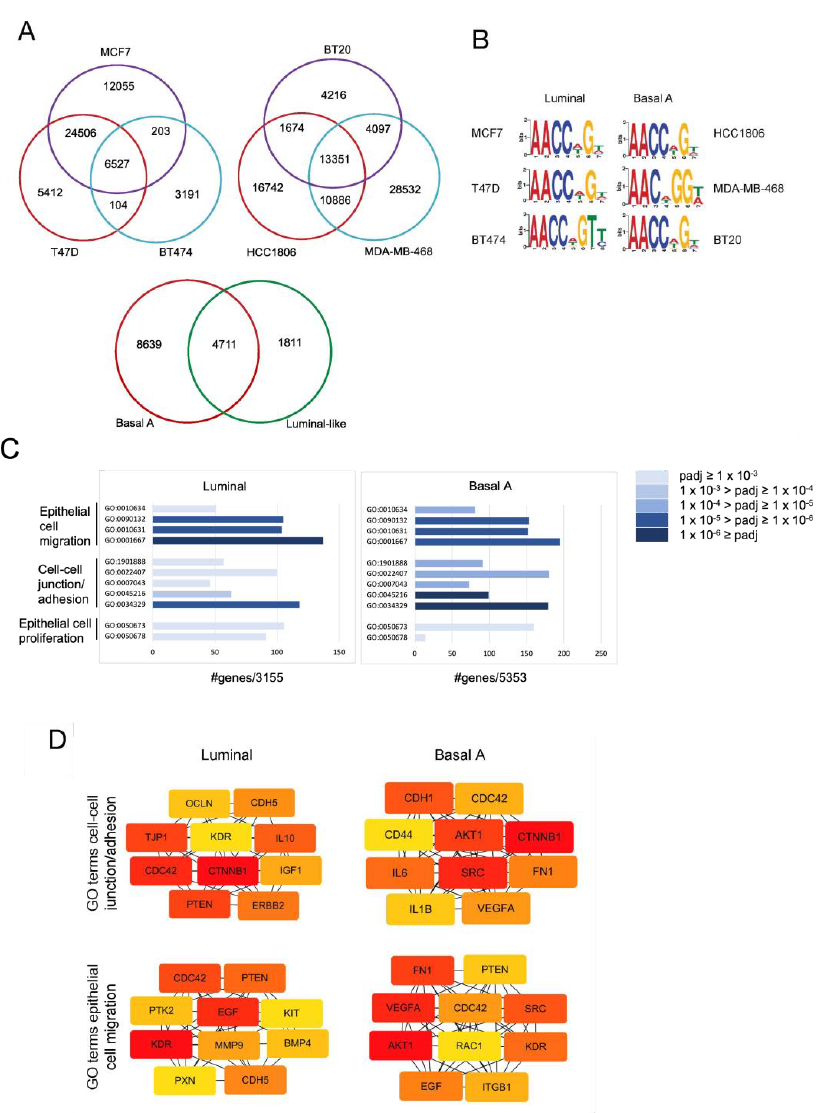
Figure 3. ChIP-seq analysis of GRHL2 target genes in luminal and basal A cells. ( A ) Venn diagrams showing overlap of GRHL2 binding sites among the indicated luminal and basal A cell lines (top panels) and overlap between shared GRHL2 binding sites in luminal and basal A cell lines (bottom panel). ( B ) GRHL2 DNA-binding motifs identified in the indicated cell lines. ( C ) Enriched GO terms associated with the indicated functions for GRHL2-occupied genes shared between all luminal (left panel) or all basal A cell lines (right panel). Color coding according to padj values in the legend. X-axis shows the number of genes involved. ( D ) Hub genes calculated by degree algorithm using Cytoscape (cytoHubba) software from the indicated GO terms for luminal and basal A cells. Color coding from red to yellow indicates the rank of the genes from top to low as assigned by cytoHubba.